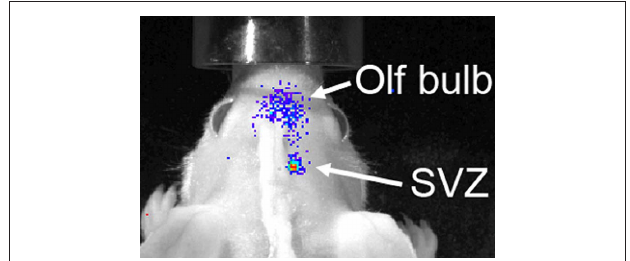
FIguRE 5 | Bioluminescence-based imaging of neurogenesis using grafted neural stem cells encoding a luciferase transgene under the control of the doublecortin promoter. Eight days after grafting in the SVZ of a wild type mouse, neuronal differentiation of implanted cells resulted into a strong bioluminescent signal. The latter partially spread from the site of graft toward the olfactory bulb as the transgenic neuroblasts migrated to their